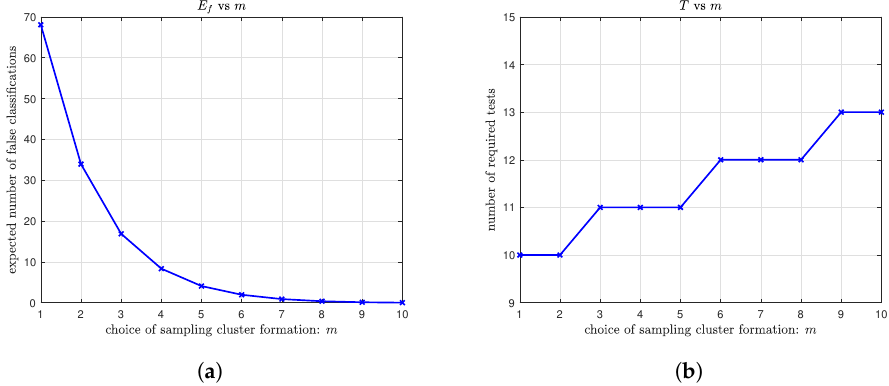
Figure 8. ( a ) Expected number of false classifications vs. the choice of sampling cluster formation F m ; ( b ) required number of tests vs. the choice of sampling cluster formation F m